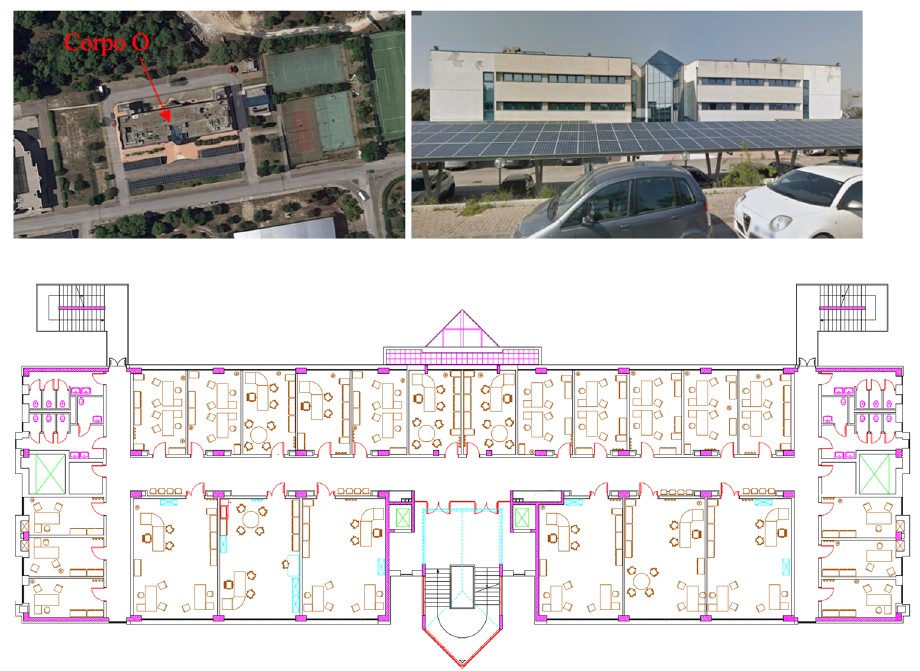
Figure 1. Building “Corpo O” at Campus Ecotekne of the University of Salento in Lecce, Italy. The building consists of two symmetrical wings (left and right wings), each of which has its own HVAC system. Each wing is composed of three floors: ground floor, first floor and second floor, with a total area of 2400 m 2 and a total volume of 13,163 m 3 . The HVAC systems are used for air conditioning of offices and labs inside the building.